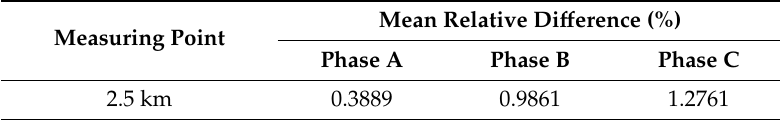
Table 3. Mean relative di ff erence of transient voltage in example 3.2.